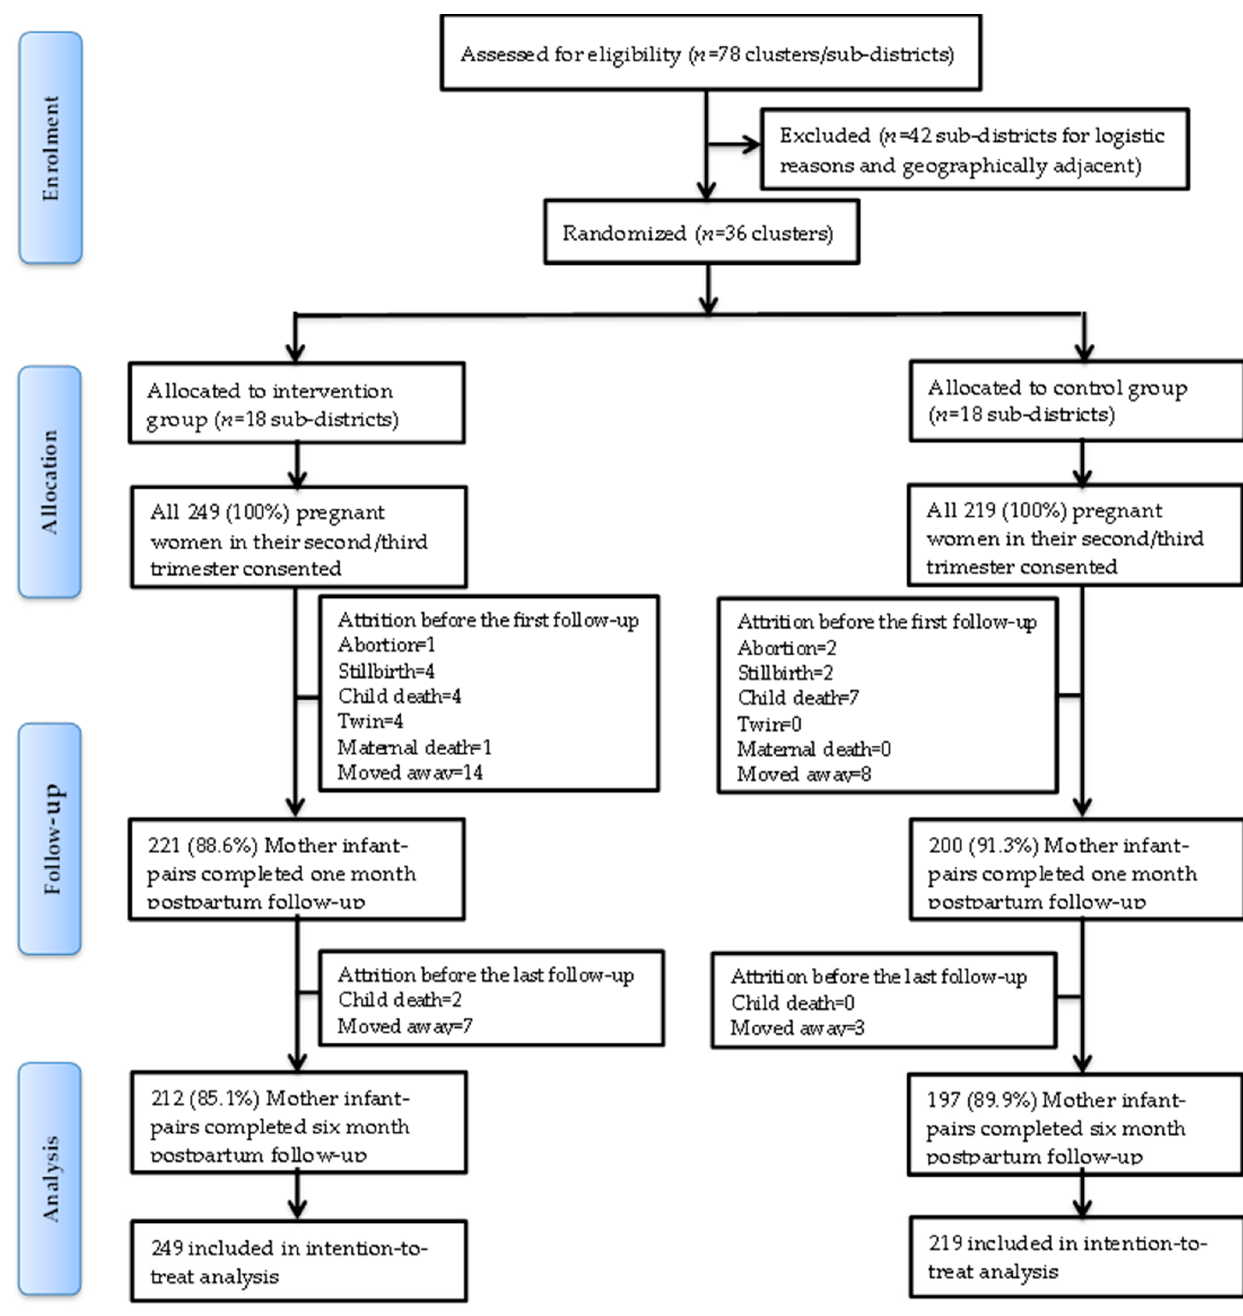
Figure 1. CONSORT (Consolidated Standards of Reporting Trials) flow diagram of the study. Table 1. Baseline characteristics of the study participants 1 .